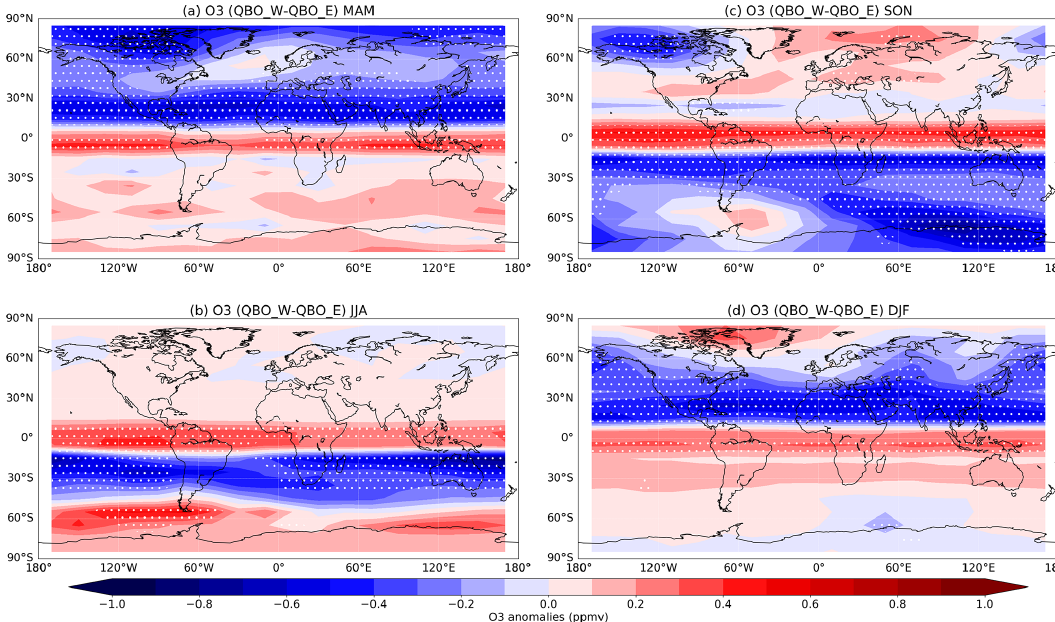
Figure 8. Influences of QBO (QBOW–QBOE) on global stratospheric ozone (10hPa), based on merged satellite data from C3S for the period 2002–2020. (a) MAM. (b) JJA. (c) SON. (d) DJF. Stippled areas indicate results that are statistically significant over the 95% level, using the two-tailed Student’s t test.